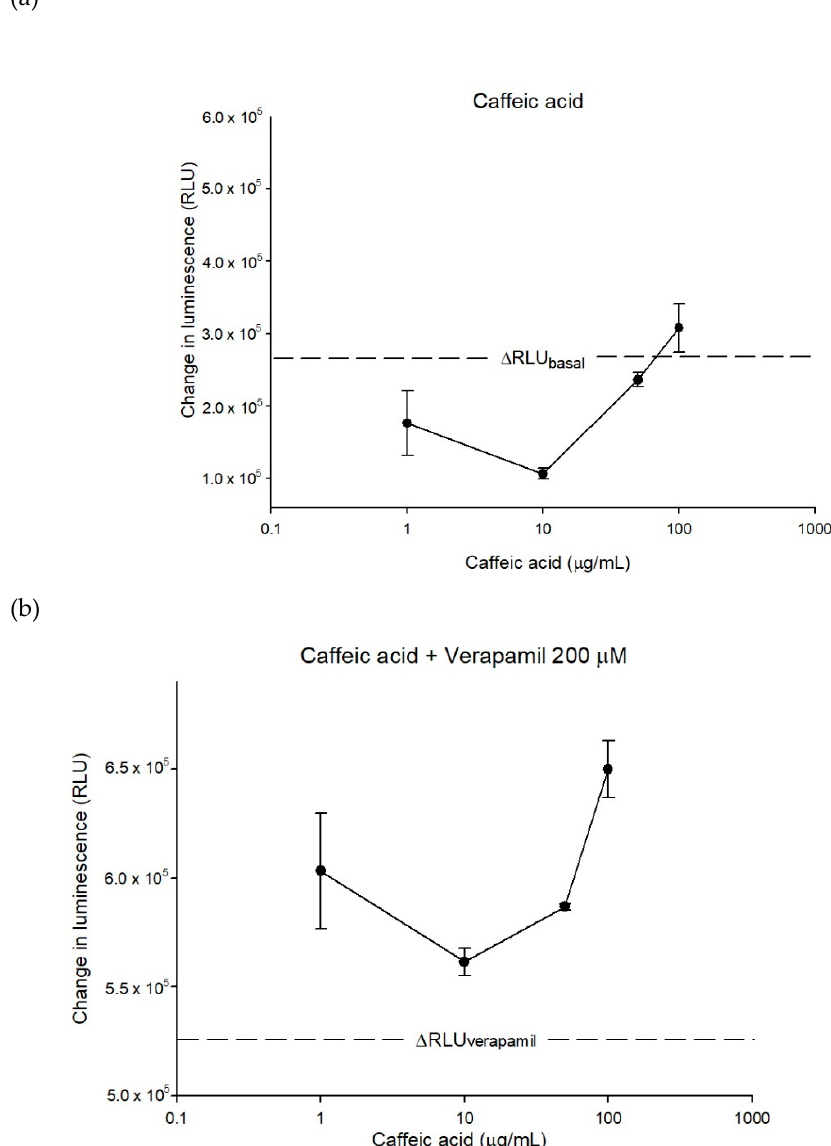
Figure 4. The P-gp ATPase modulating effects of caffeic acid. ( a ) Caffeic acid stimulated ATPase activity dose-dependently (10–100 μ g/mL). ( b ) The verapamil-stimulated ATPase activity was further stimulated by caffeic acid. Data were analyzed in terms of the change of luminescence ( Δ RLU). Data were presented as mean ± SE of at least three experiments, each in triplicate.